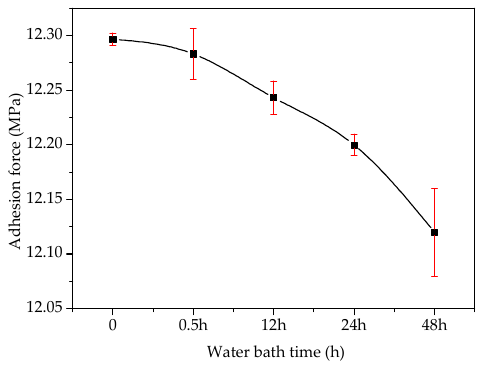
Figure 5. Effect of the water bath environment on the adhesion at the asphalt–steel slag interface.